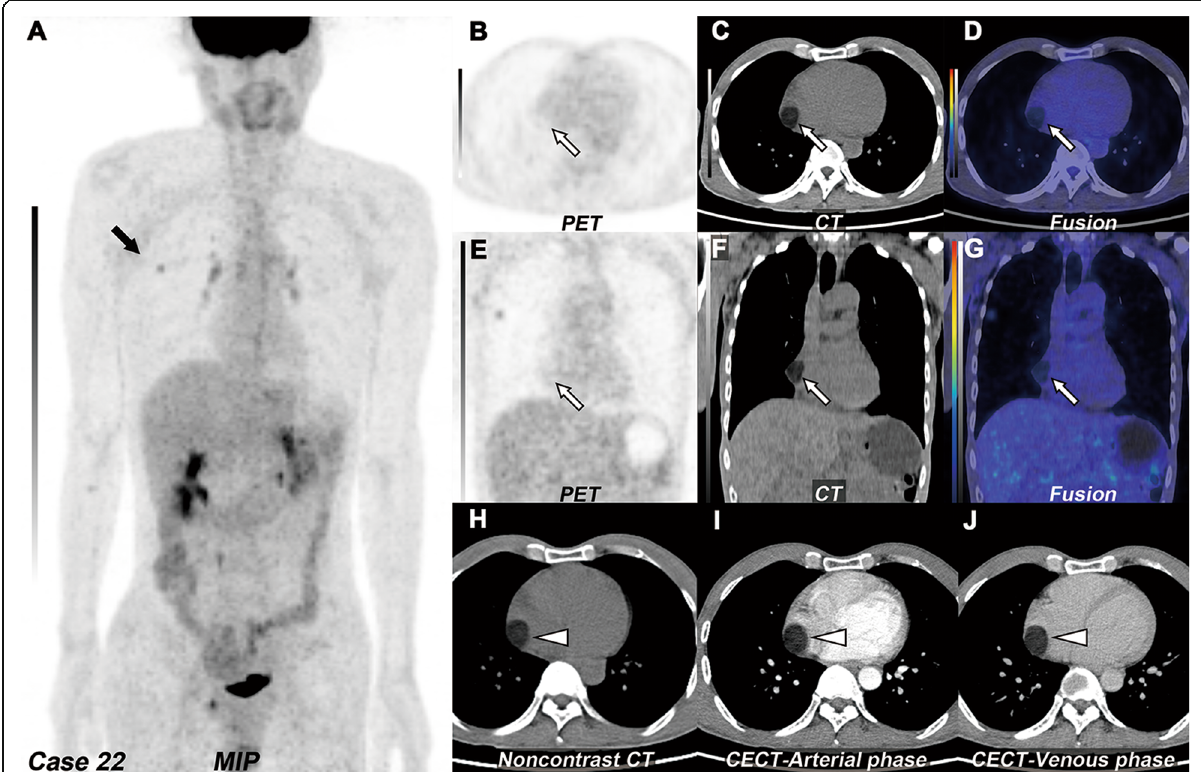
Fig. 1 Right atrial lipoma. a MIP of 18 F-FDG PET/CT revealed lung cancer with increased 18 F-FDG uptake in the right upper lobe (black arrow). b – d The transverse and e – g coronal view of selected PET, CT, and fused PET/CT images revealed a well-circumscribed solitary mass, which located in the right atrium (white arrow, SUVmax 0.8). h On the non-contrast CT, the tumor presented as sharply margin, ovoid shape with fat density; the CT attenuation value was − 50 HU (white arrowhead). i – j The transverse view of arterial and venous phases of CECT images revealed